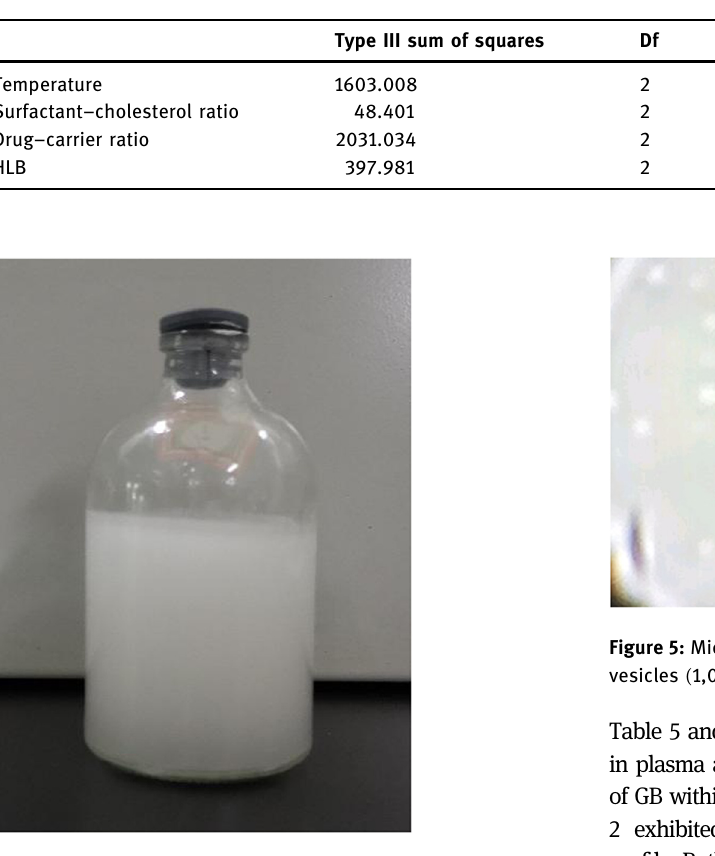
Figure 3: Niosomal complex suspension.